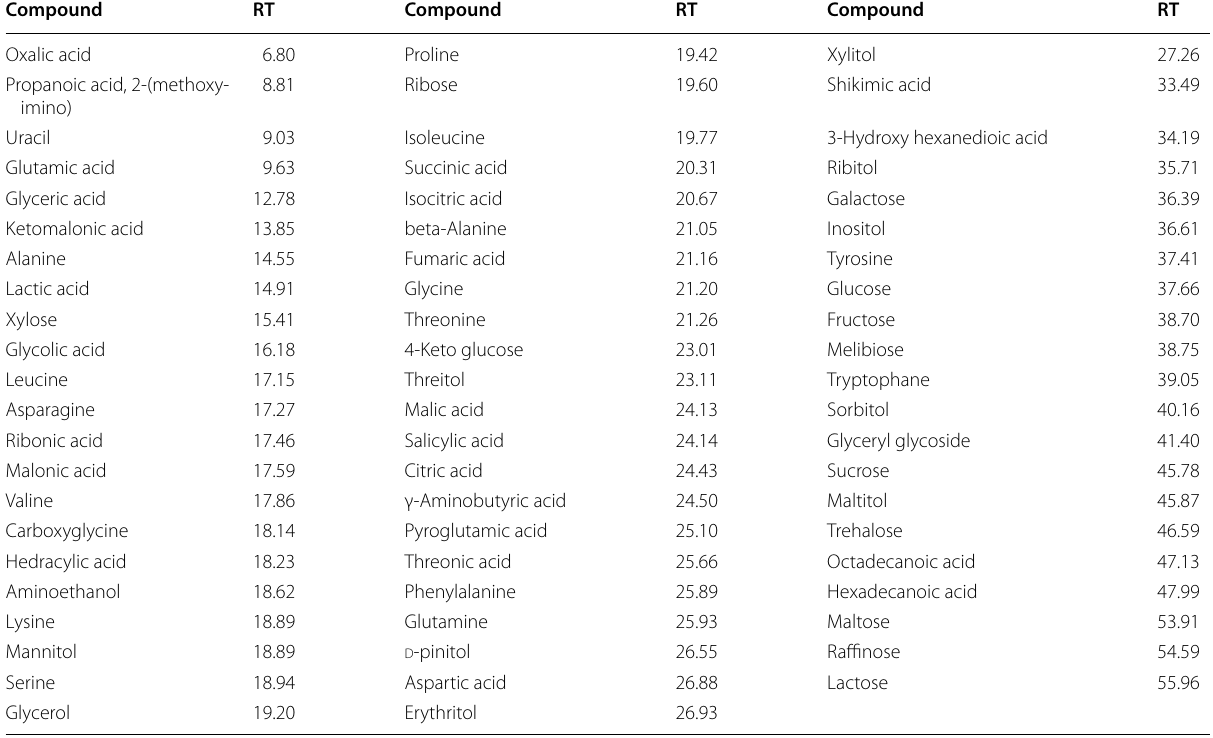
Table 1 Chromatographic and spectrometric data for 64 metabolites from soybean leaves analyzed by